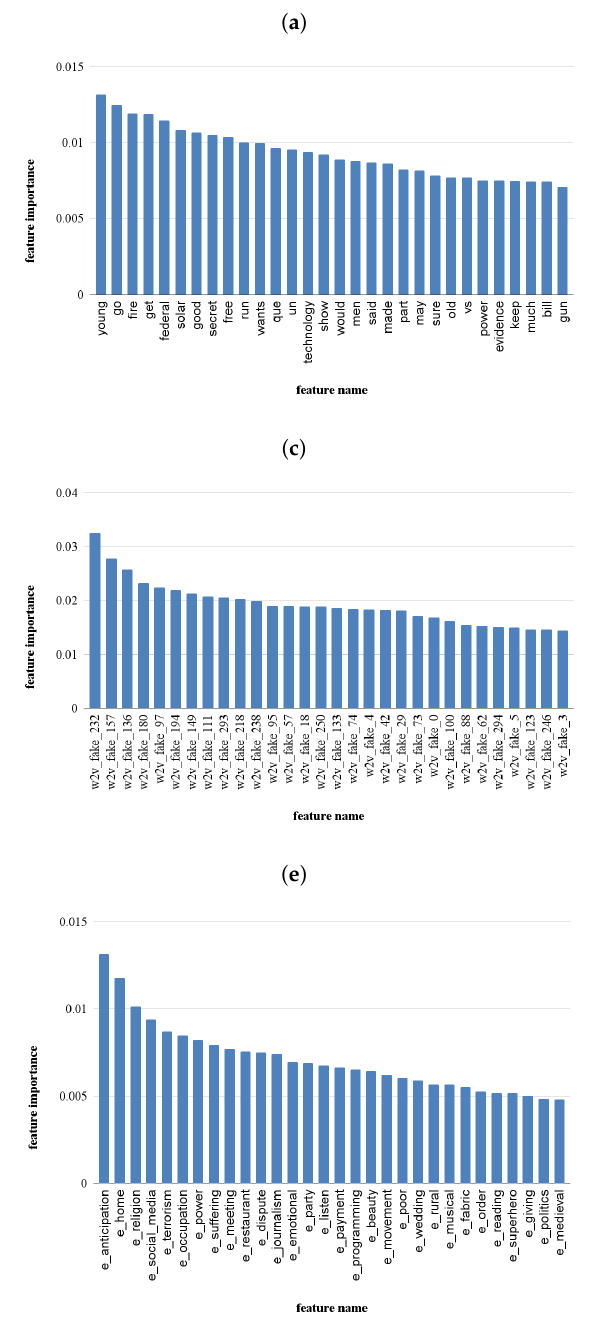
Figure 3. Importance of 30 most relevant features from different feature sets using a 15-day interval. In some scenarios, due to preprocessing applied (removal of low variance and highly correlated features), total number of features is inferior to 30. ( a ) Bag of Words; ( b ) Google Word2Vec; ( c ) Fake Word2Vec; ( d ) Context-free features; ( e ) Lexical Categories